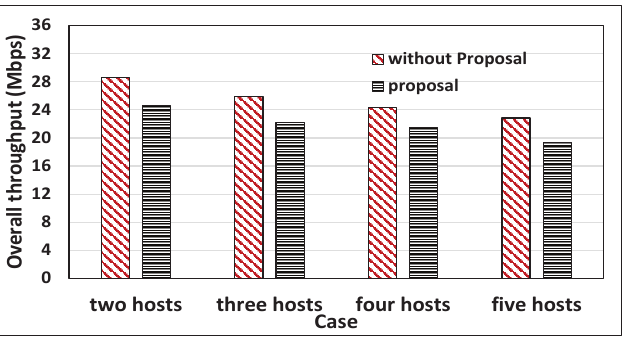
Figure 16. Total throughput comparisons for with and without proposal for iperf traffic.